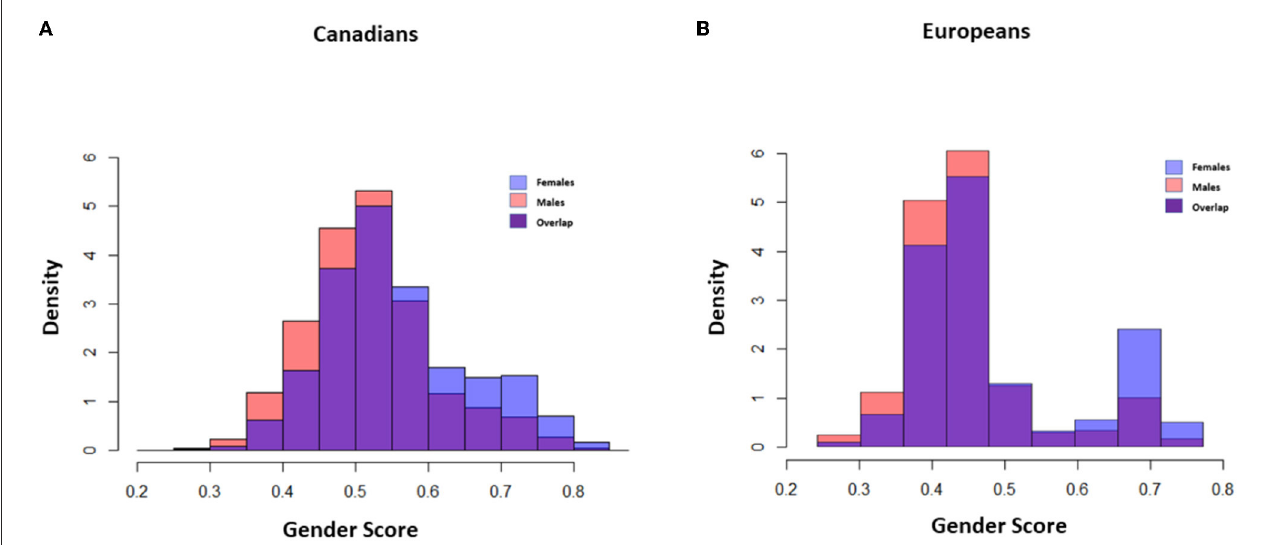
FIGURE2 Gender score distribution in Canadians and Europeans. Density Plot: Y Axis: probability density of gender, X Axis: gender score I: Gender score distribution in male and females in Canadian (A) and European populations (B) . Red, Gender score in males; Blue, Gender score in females; Purple, Overlapping of Gender score in both groups. Higher gender score demonstrates characteristics traditionally ascribed to women in the population. The distribution of the gender score in men and women did not entirely overlap with biological sex in both populations which shows their partially independent effect. Moreover, the distribution was more polarized in Europeans and there was less overlap between roles in the